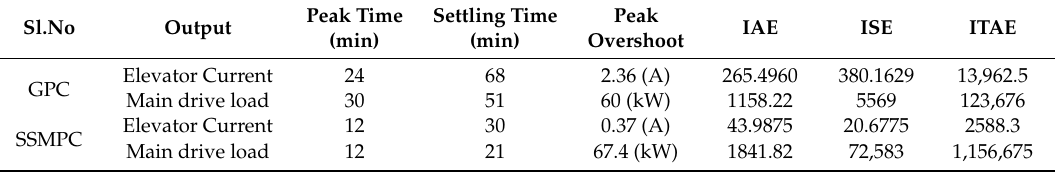
Table 1. Time-domain specifications and performance indices for different predictive controllers.